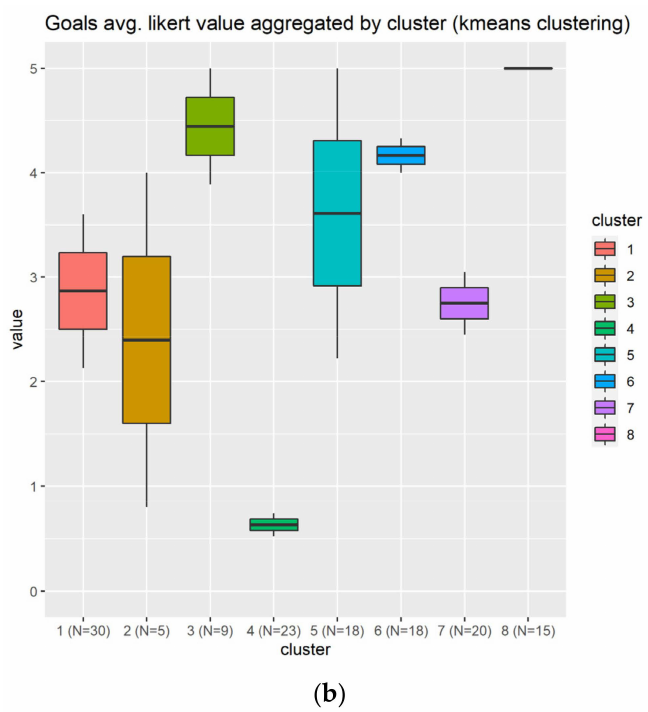
Figure 15. The goals generated eight cluster groups, where only three of them respond positively to those elements. Subfigure ( a ) indicate the two questions in detail, meanwhile ( b ) shows the boxplots of the